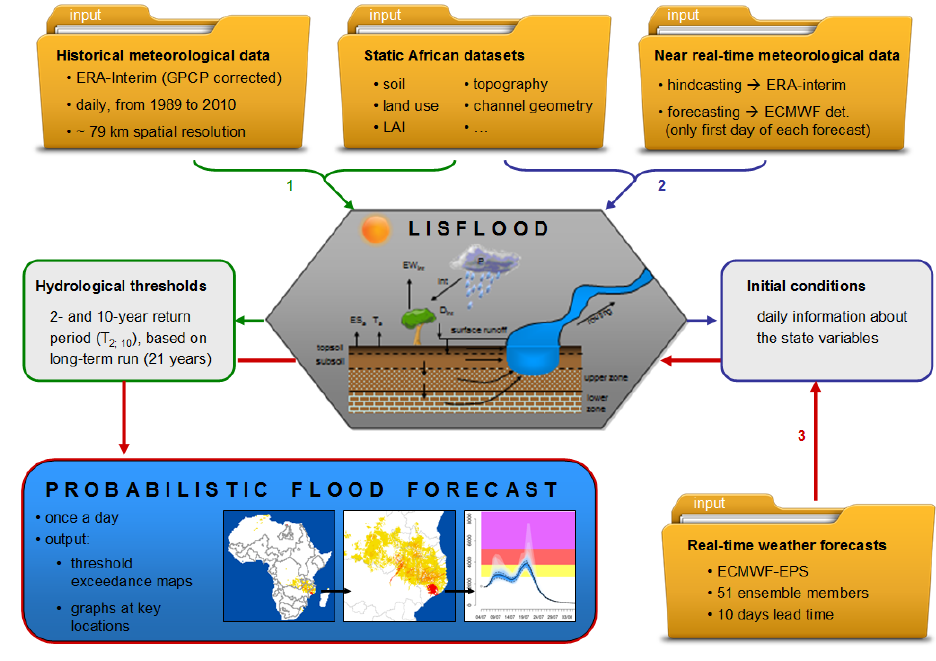
Figure 3. Schematic overview of AFFS.